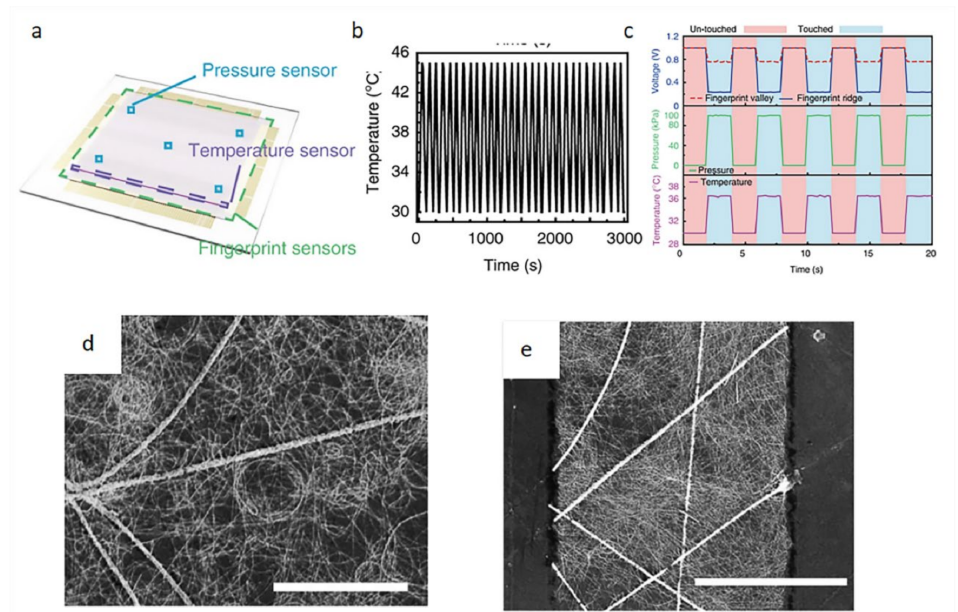
Figure 10. Sensor schematic diagram and performance characterization diagram. ( a ) Sensor schematic diagram; ( b ) stability graph with repeated loading and unloading; ( c ) sensor real-time sensorgram; ( d , e ) SEM images of hybrid electrode and patterned hybrid electrode